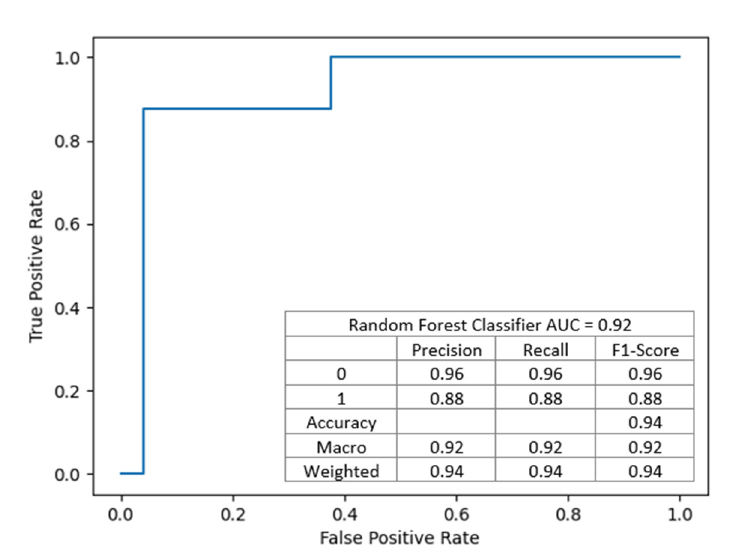
Figure 6. This model achieved a slightly better differentiation power of classes given by AUC = 0.92.